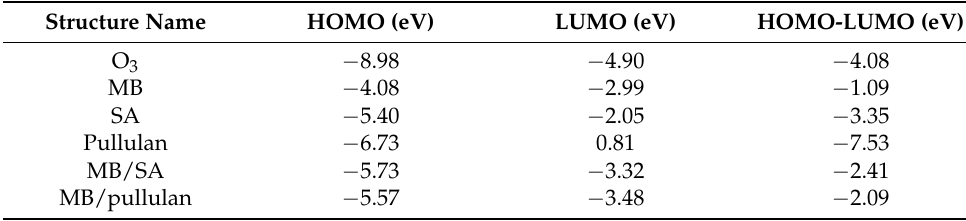
Table 3. HOMO and LUMO energy levels at the B3LYP/6-31G(d)